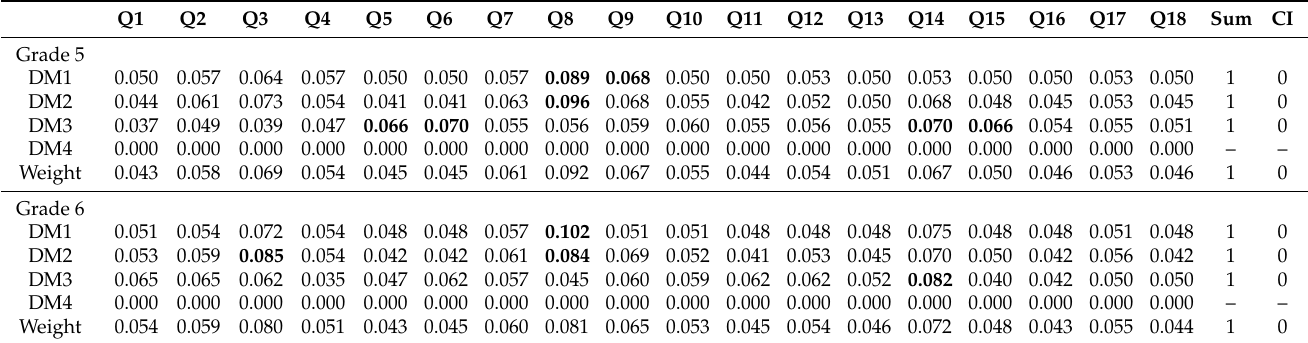
Table 3. The weight and the ranking of VGAS criteria for grades 5 and 6.